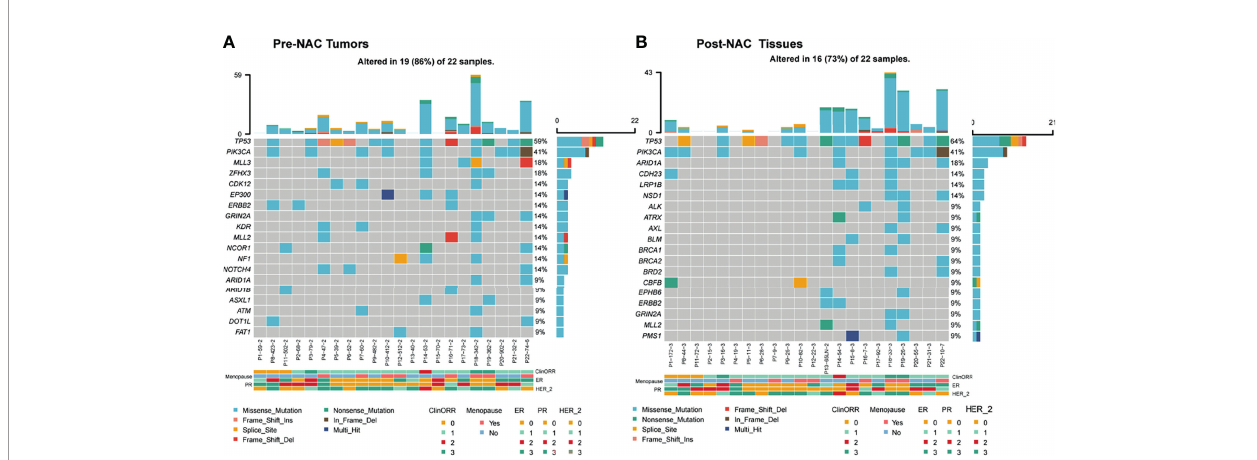
FIGURE 4 | Landscape of genomic alterations in pre-NAC tumors and post-NAC residual non-cancerous tissues (pCR) or cancerous tissues (non-pCR). (A) In pre- NAC tumors, the top 15 mutated genes were TP53, PIK3CA, MLL3, ZFHX3, CDK12, EP300, ERBB2, GRIN2A, KDR, MLL2, NCOR1, NF1, NOTCH4, ARID1A , and ARID1B . (B) In post-NAC residual non-cancerous tissues (pCR) or cancerous tissues (non-pCR), the top 15 mutated genes were TP53, PIK3CA, ARID1A, CDH23, LRP1B, NSD1, ALK, ATRX, AXL, BLM, BRCA1, BRCA2, BRD2, CBFB , and EPHB6 . cliniORR, clinical objective response rate; menopause, menopause; ER, estrogen receptor; PR, progesterone receptor; HER-2_, human epidermal growth factor receptor 2. Missense_mutation, nonsense mutation; frame_shift_ins, frame shift insertion mutation; spice_site, splicing mutation; frame_shift del, Frameshift deletion mutation, nonsense mutation, nonsense mutation, in frame del, frameshift deletion mutation, multi hit, multiple site mutation of a same gene; ClinORR 0: Complete Response (CR), 1: Partial Response (PR), 2: Stable Disease (SD), 3: Progressive Disease (PD); ER, PR, HER_2, 0: Negative, 1: +, 2: ++, 3: